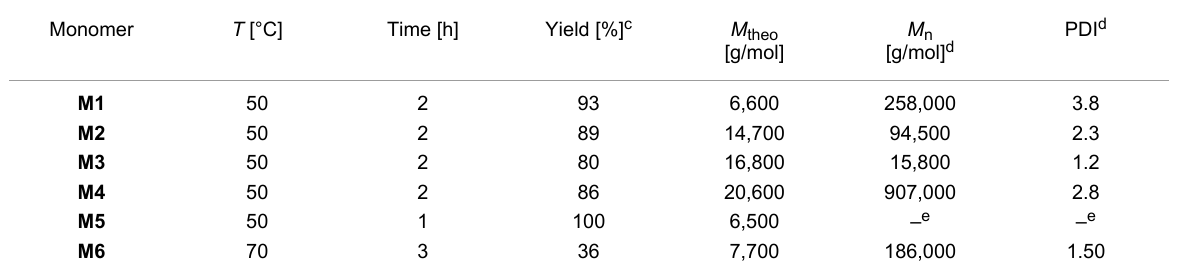
Table 2: ROMP reactions under biphasic conditions. a,b